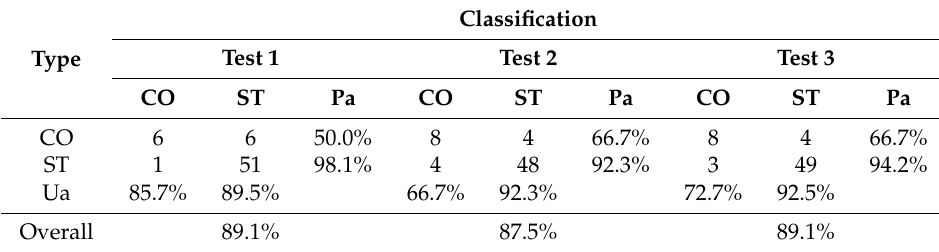
Table 8. RF classification results of different tests (CO = totally collapsed building, ST = standing samples from Image 3 (8 April 2015) and Image 2 (8 December 2014), respectively. In Test 3, the